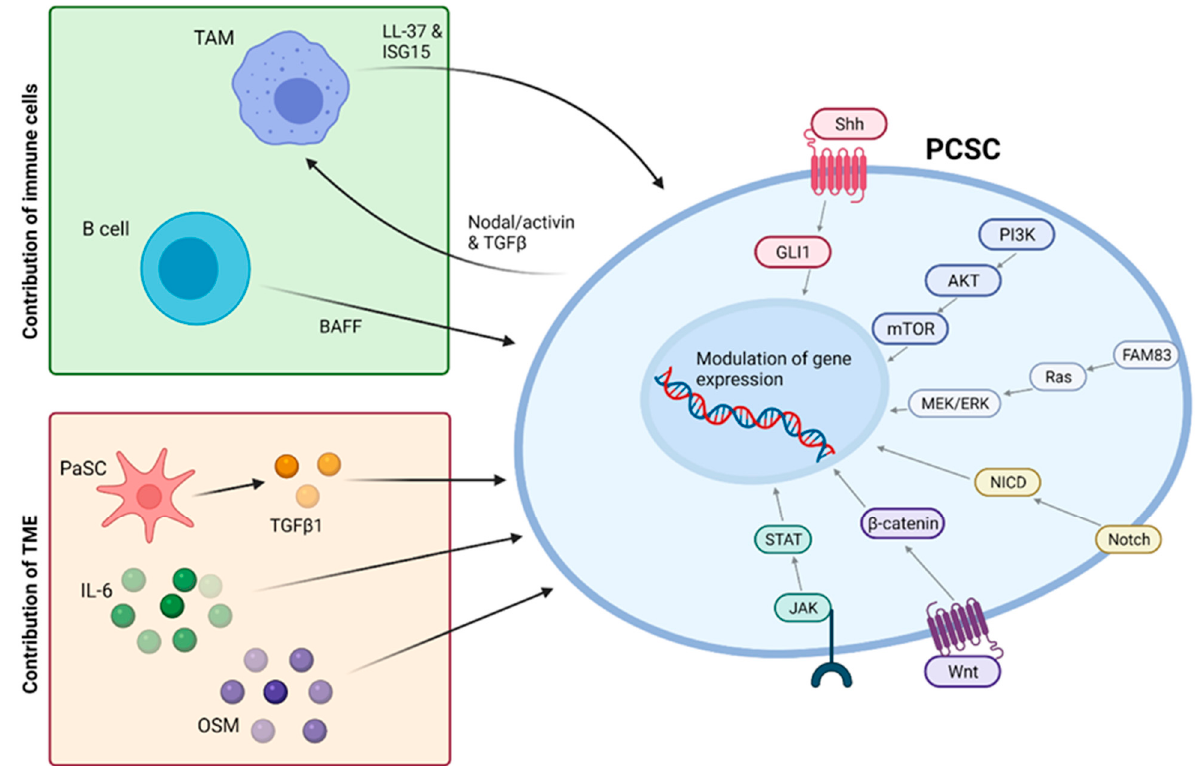
Figure 4. Pathways promoting cellular plasticity in PCSCs. Top left: Immune cells are known to play an important role in CSC plasticity, with the production of B-cell activating factor (BAFF) by infiltrating B lymphocytes inducing EMT and enhancing the motility of pancreatic epithelial cells. Tumour-associated macrophages (TAMs) secrete the immune modulatory peptide LL-37, which enhances stemness and sphere formation. The secretion of Nodal/Activin and TGF β -1 by CSCs stimulates further LL-37 secretion to generate a positive feedback loop. TAMs also secrete interferon-stimulated gene 15 (ISG-15), which enhances CSC self-renewal, pluripotency, and invasion. Bottom left: The tumour microenvironment (TME) influences CSC emergence, with the addition of TME cytokines to tumour cells resulting in the acquisition of stem cell characteristics. Transforming growth factor beta (TGF β ), interleukin 6 (IL-6), and oncostatin (OSM) all induce mesenchymal/CSC properties. Pancreatic stellate cells (PaSCs) are known to induce CSC properties in neighbouring cells, which could be mediated in part by the production of TGF β . Right: Multiple signalling pathways evoke plasticity, including mTOR, sonic hedgehog (Shh), Notch, Wnt, and Stat. Family with Sequence Similarity 83 (FAM83) proteins have been shown to drive cellular transformation, with FAM83A driving PDAC cell survival via the MEK/ERK signalling pathway.